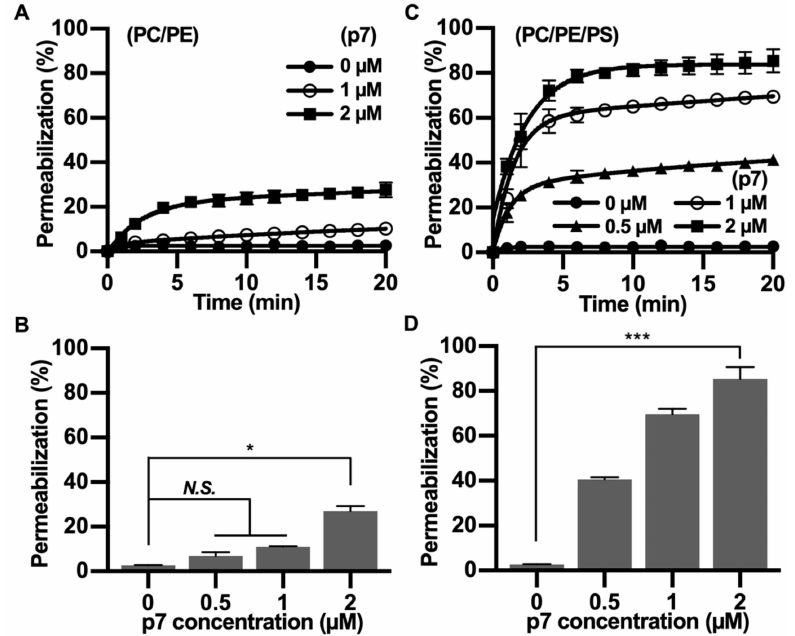
Figure 3. p7-induced large unilamellar vesicles (LUVs) permeabilization in the presence of PS. ( A , C ) p7-induced LUV permeabilization. CF-encapsulated LUVs composed of PC:PE, 3:1 ( A ), or PC:PE:PS, 3:1:1 ( C ) were incubated with the indicated concentration of p7, and fluorescent signals were recorded by spectrophotometry (Fluoroskan Ascent FL, Thermo Labsystems, Loughborough, UK). ( B , D ) p7-induced liposome permeabilization was quantified at 20 min with CF-encapsulated LUVs composed of PC:PE, 3:1 ( A ), or PC:PE:PS, 3:1:1 ( C ). Data are presented as the mean ± SD and analyzed with 3-way ANOVA. * p ≤ 0.05, *** p ≤ 0.001. CF,